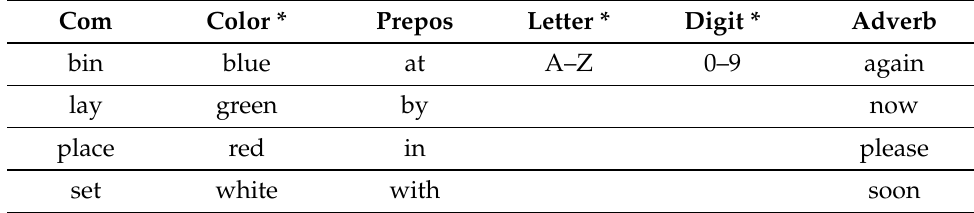
Figure 6. Alignment between the video frames and the character output.